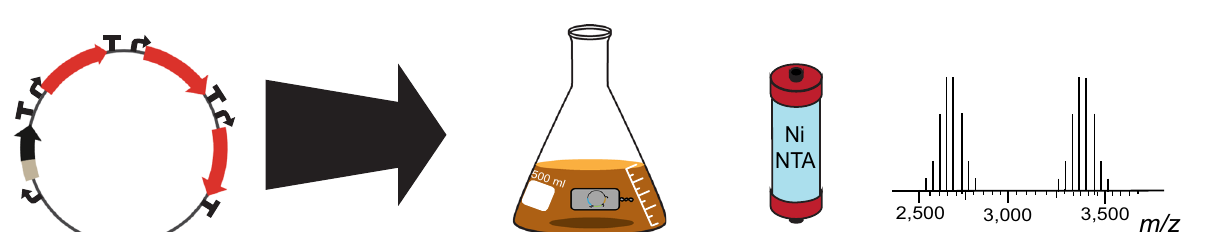
Fig. 3 | Success rate and fi delity ofpathway refactoring. a Results of refactoring among different investigated RiPP classes. LanI, class I lanthipeptide; LanII, class II lanthipeptide; LanIII, class III lanthipeptide; LanIV, class IV lanthipeptide; Gra, graspetide; Epi, epipeptide; Lin, linaridin; Glk, glycocin; Las, lasso peptide; Ran, ranthipeptide; Sac, sactipeptide; Lap, linear azol(in)e-containing peptide; Tha, thioamitide; Thp, thiopeptide. Effect of the number of genes on b refactoring